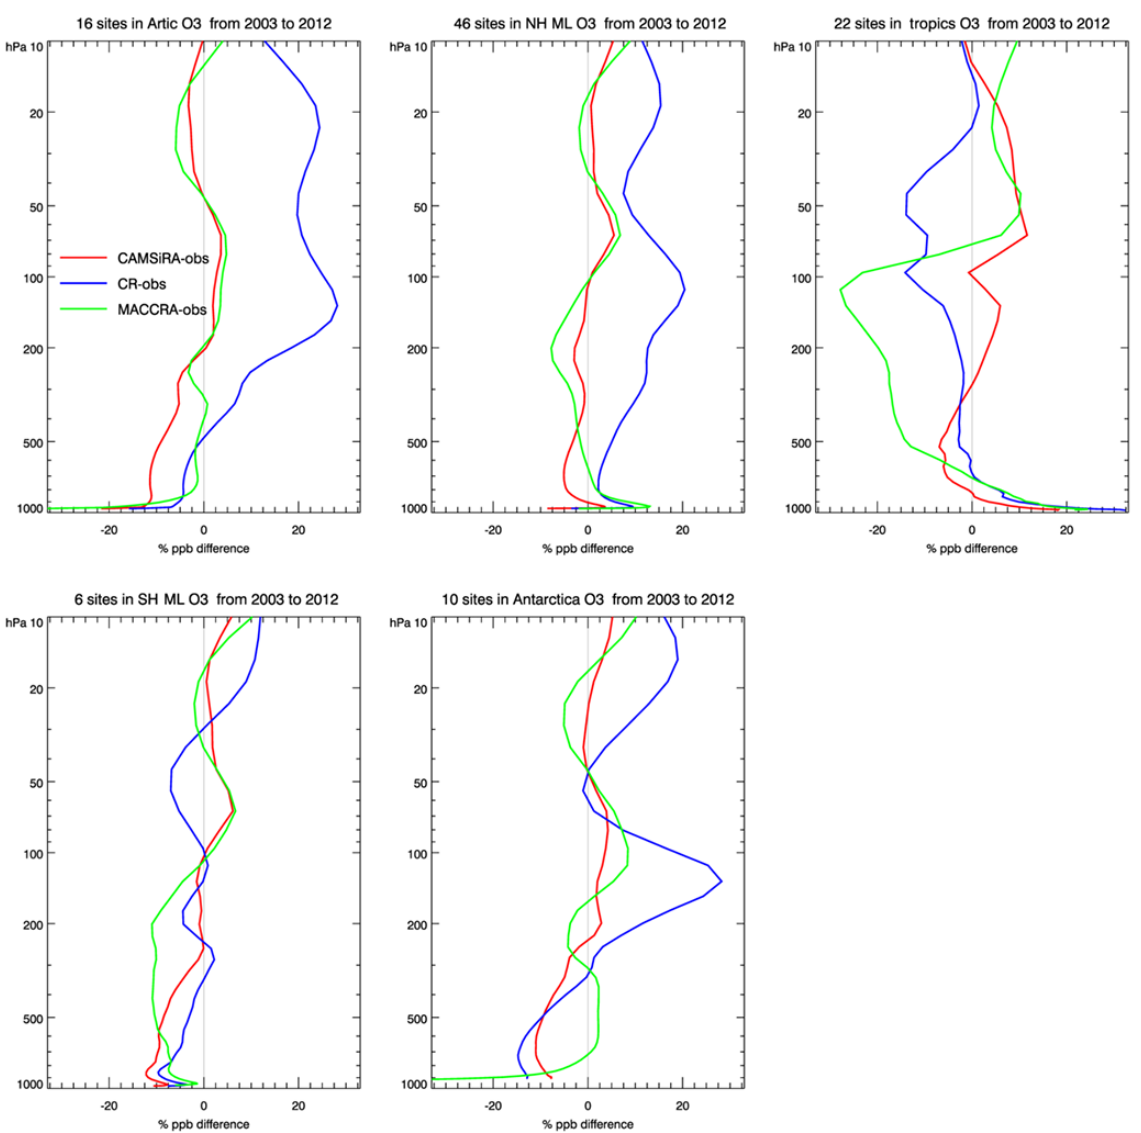
Figure 17. Mean relative bias of CAMSiRA (red), MACCRA (green) and the CR (blue) compared with ozone sondes in the Arctic (top left), NH mid-latitudes (top middle), tropics (top right), SH mid-latitudes (bottom left) and Antarctica (bottom middle) for the period